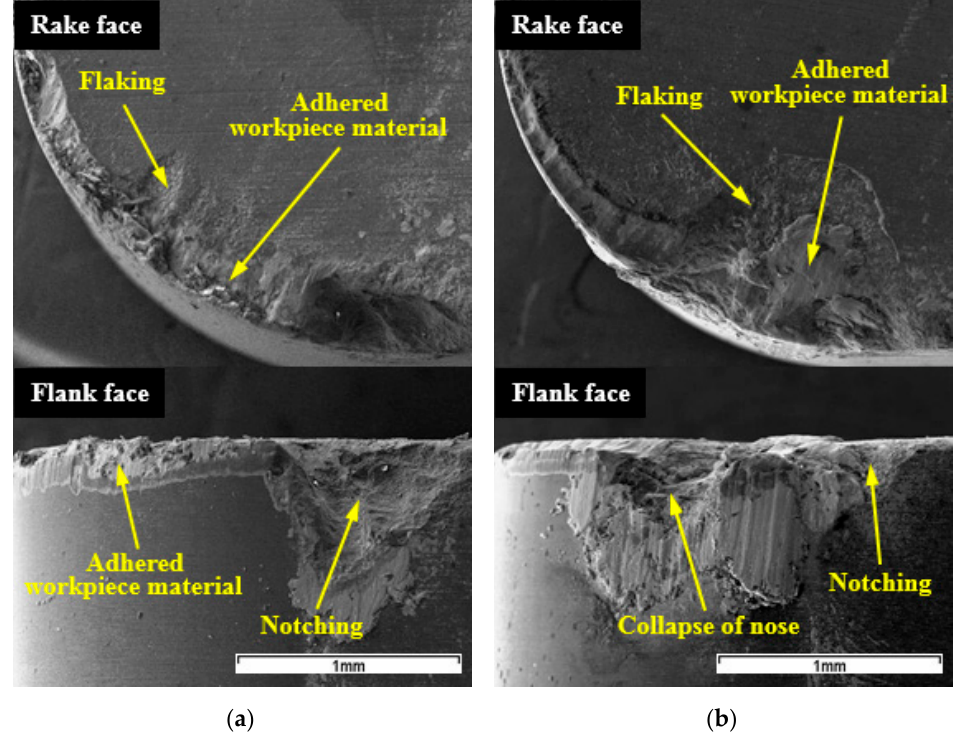
Figure 3. SEM micrographs of wear morphologies of WG300 at: ( a ) 190 m/min; ( b ) 370 m/min. Compared with WG300, adhesion of workpiece material onto the worn faces was relatively uniform for SX9. As seen from SEM micrographs of SX9 (Figure 4), apparent ridges and grooves perpendicular to the cutting edge were generated on the flank face.